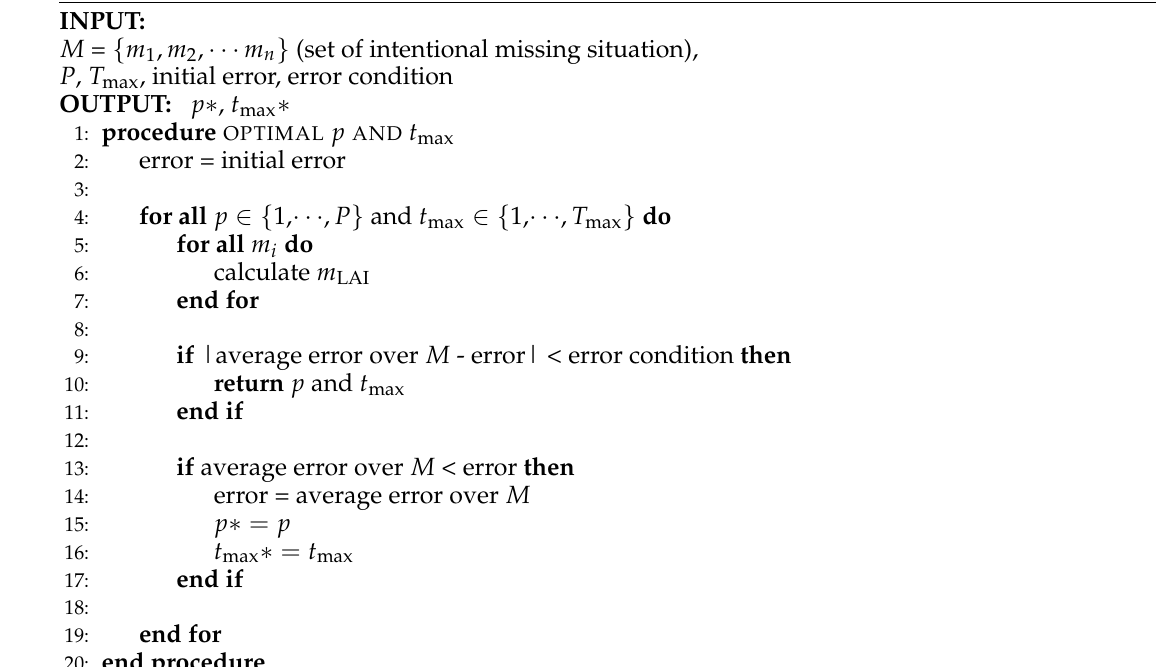
Algorithm 1 Learning algorithm for optimal p and t max